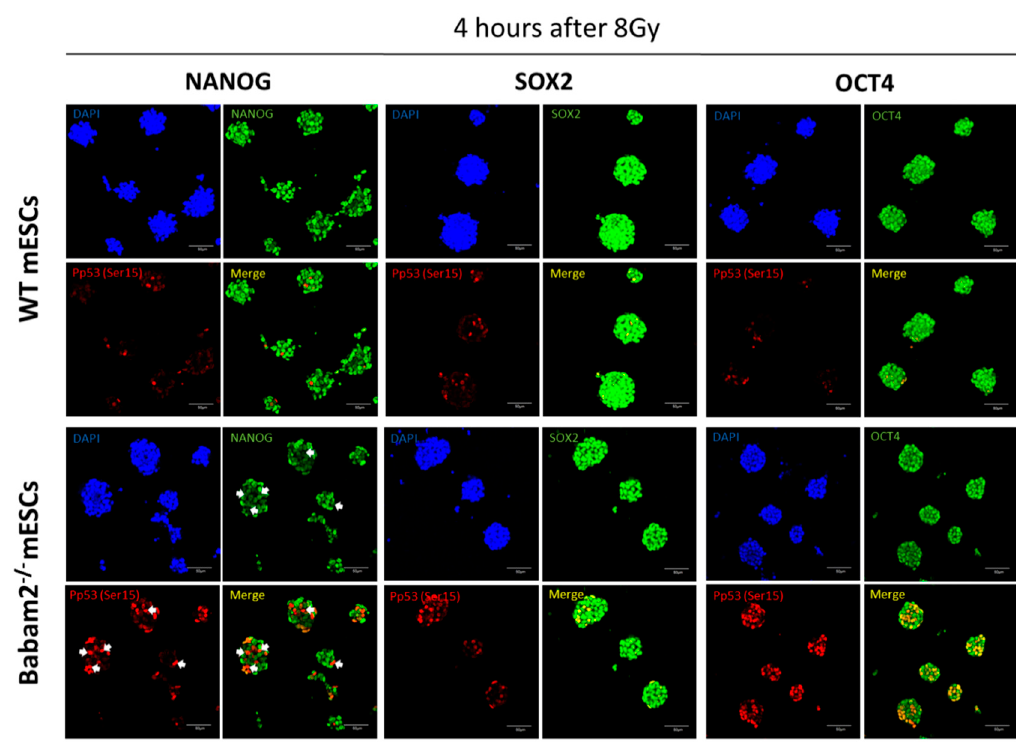
Figure 5. pp53 inhibits NANOG expression in mESCs. Co-immunofluorescence staining of WT and Babam2 − / − mESCs at 4 h after 8 Gy of gamma irradiation for pp53 (ser15) with NANOG, SOX2, and OCT4, respectively. Cells expressing pp53 do not express NANOG (as indicated by the white arrows) but still express SOX2 and OCT4. Scale bar = 50 µ m.